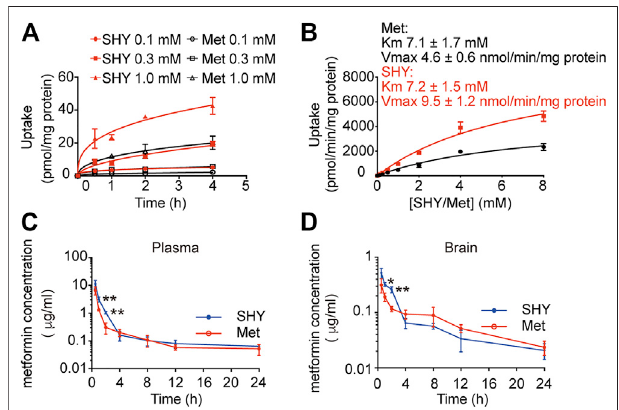
FIGURE 3 | Pharmacokinetic pro fi les of metformin in microglial cells in vitro and rats in vivo . (A) BV-2 microglial cells were incubated with different concentration of SHY-01 (SHY) or metformin hydrochloride (Met) for the indicated periods, supernatants were discarded and cells were lysed for intracellular metformin analysis by LC-MS. Data were expressed as mean ± SD ( n = 3). (B) Uptake of metformin (15 min) into BV-2 microglia cells incubated with different concentrations of SHY-01 (SHY) or metformin hydrochloride (Met). The Michaelis-Menten equation with one saturable component was fi t to the corrected uptake rate and the estimated Km and Vmaxvaluesarepresented. (C) Plasmaandbrainconcentration-timepro fi leof metformin after intraperitoneal injection of SHY-01 in rats. SHY-01 (SHY, 50 mg/kg) or metformin hydrochloride (Met, 50 mg/kg) were administrated ( i.p. ) to rats. Blood samples were taken from fundus venous plexus at 0, 15, 30, and 60 min, 2, 4, 8, 12, and 24 h after injections. Concentrations of metformin in plasma was analyzed by LC-MS/MS. (D) Rats were sacri fi ced and brains were assessed at 0, 15, 30, and 60 min, 2, 4, 8, 12, and 24 h after injections. Concentrations of metformin in brain tissue were analyzed by LC- MS/MS. Results are expressed as mean ± SD ( n = 3 rats/group). Two-tailed unpaired Students ’ t -test was used to analyzing the difference between SHY- and Met-treated groups in each time point. p p < 0.05, pp p < 0.01 versus the Met-treated group.